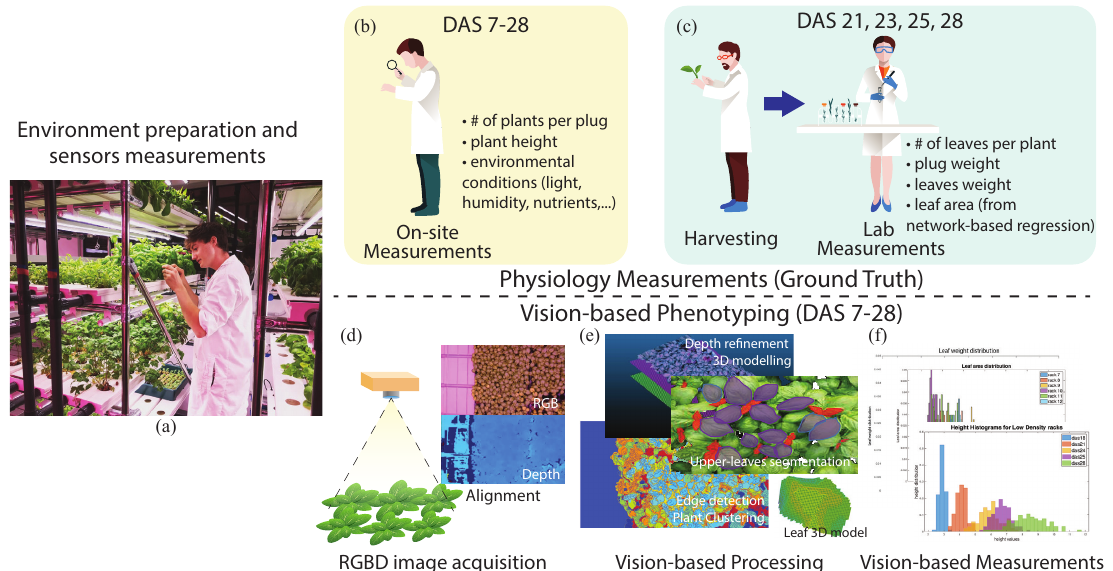
Figure 1. The figure shows the schema of the two parallel computational processes leading to automatic measurements: the experiment setting ( a ); the manual data collection via on-site ( b ) and lab measurements ( c ); the images acquisition and alignment ( d ); and the ML and CV methods ( e ) to predict phenotype features, such as plants height, leaf area, and leaf weight ( f